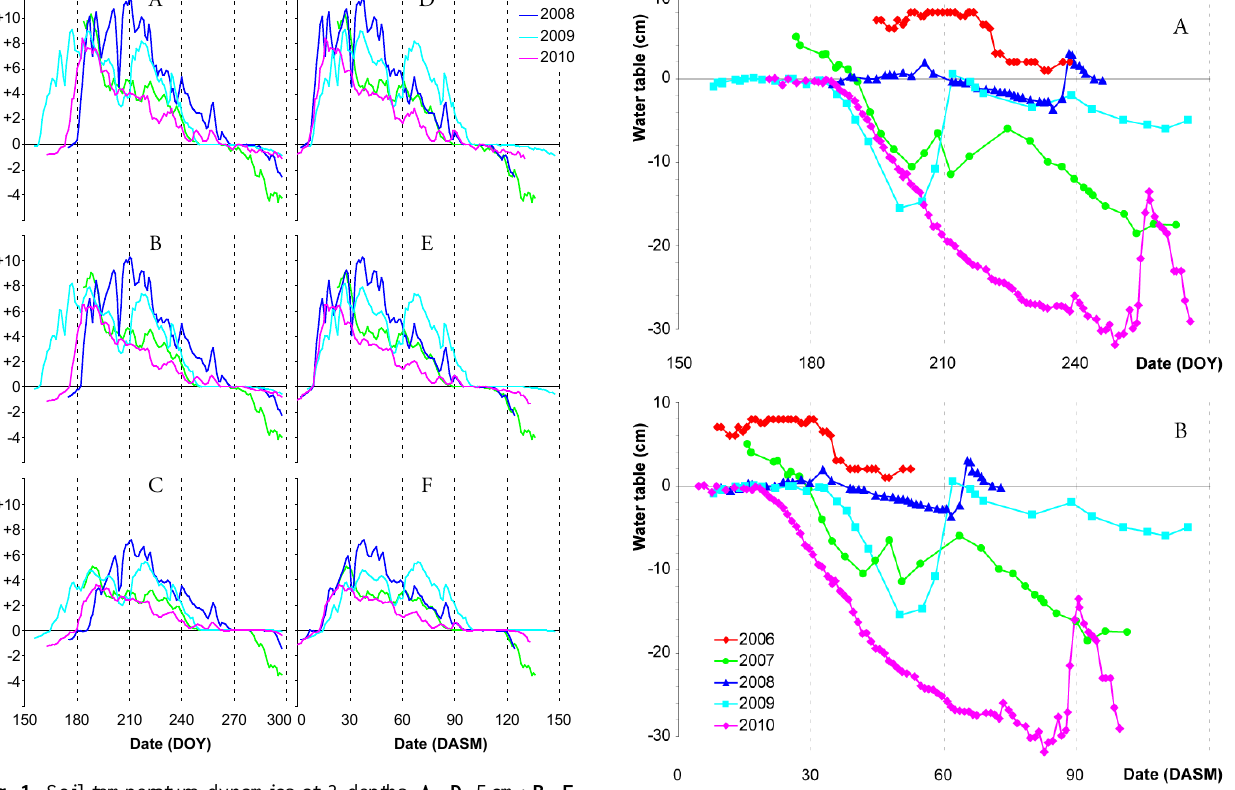
Fig. 2. Water table level dynamics. A normalized to day of year (DOY); B normalized to day after snowmelt